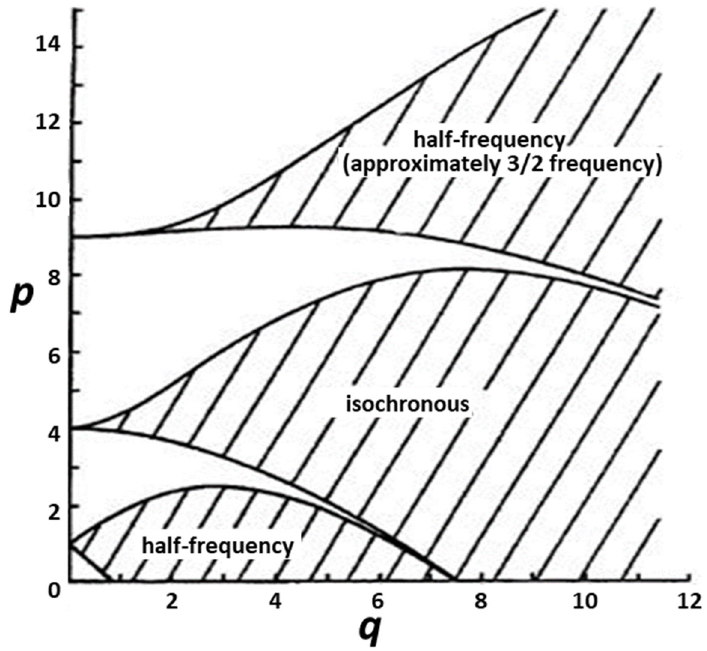
Figure 1. Stability chart for the solutions of Mathieu’s equation. Reprinted from Benjamin and Ursell [18].